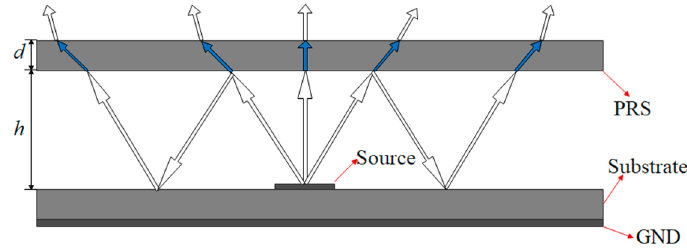
Figure 1. Fabry–P é rot resonant cavity Figure 1. Fabry–Perot resonant cavity antenna.